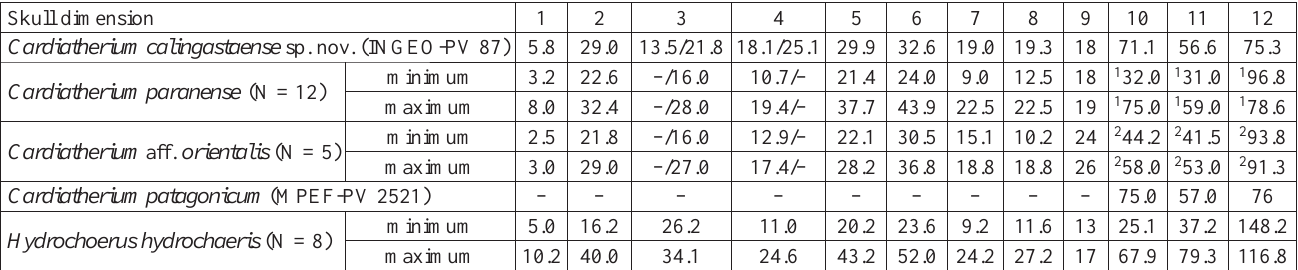
Table 1. Comparison of skull dimensions (in mm, except for 9, 12) of Cardiatherium calingastaense sp. nov. following Vucetich et al. (2014b) with other late Miocene Cardiatherium and Recent Hydrochoerus hydrochaeris . Abbreviations: 1, posterior width of the incisive foramen; 2, rostral width at the anterior margin of the anterior root of the zygomatic arch (complete or up to the midline in incomplete specimens); 3, width between the anteriormost points of the scars marking the origin of the masseter medialis muscle; 4, rostral width at the level of P4, measured at the alveolar margin of prism I; 5, rostral width at the posterior margin of the anterior root of the zygomatic arch (complete or up to the midline in incomplete specimens); 6, rostral width at the level of M2, measured at the alveolar margin of prII; 7, distance between the posterior margin of the incisive foramen and P4; 8, P4–M1 anteroposterior length; 9, angle of the beginning of the ventral anterior zygomatic arch and the alveolar series, in lateral view; 10, length of upper diastema; 11, length of P4–M3; 12, relationship (%) between dimensions 10 and 11; 1 holotype of C. paranense and MLP 71-VI-16-1; 2 GHUNLPam 27389 (the smallest) and GHUNLPam 5274 (the largest). Skull dimension